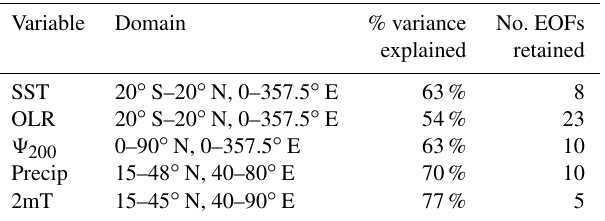
Table 1. LIM variables that compose the state vector x , their do- main, and the percent (%) variance explained by the retained em- pirical orthogonal functions (EOFs). Variables include the 200hPa streamfunction ( (cid:57) 200 ), the 2m temperature (2mT), the sea surface temperature (SST), and outgoing longwave radiation (OLR). Pre- cipitation (Precip) from the Climate Hazards group Infrared Precip- itation with Stations (Funk et al., 2015) Version 2.0 dataset (https: //data.chc.ucsb.edu/products/CHIRPS-2.0/, last access: 21 October 2021) is also used. JRA-55 and CHIRPS are used because they are available in near real time (2–3d lag) and serve as the basis for experimental real-time forecasts and because they are available back to at least 1982. (cid:57) 200 , SST, and OLR anomalies are used on a 2.5 × 2.5 ◦ horizontal grid, while 2mT and Precip are used on a 0.5 × 0.5 ◦ grid. The EOFs and principal components (PCs) retained in x are not sensitive to the gridding used (not